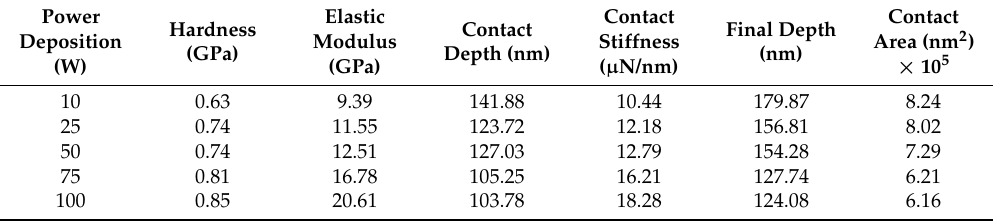
Table 4. Mechanical properties of geranium oil-derived thin polymer films fabricated at various